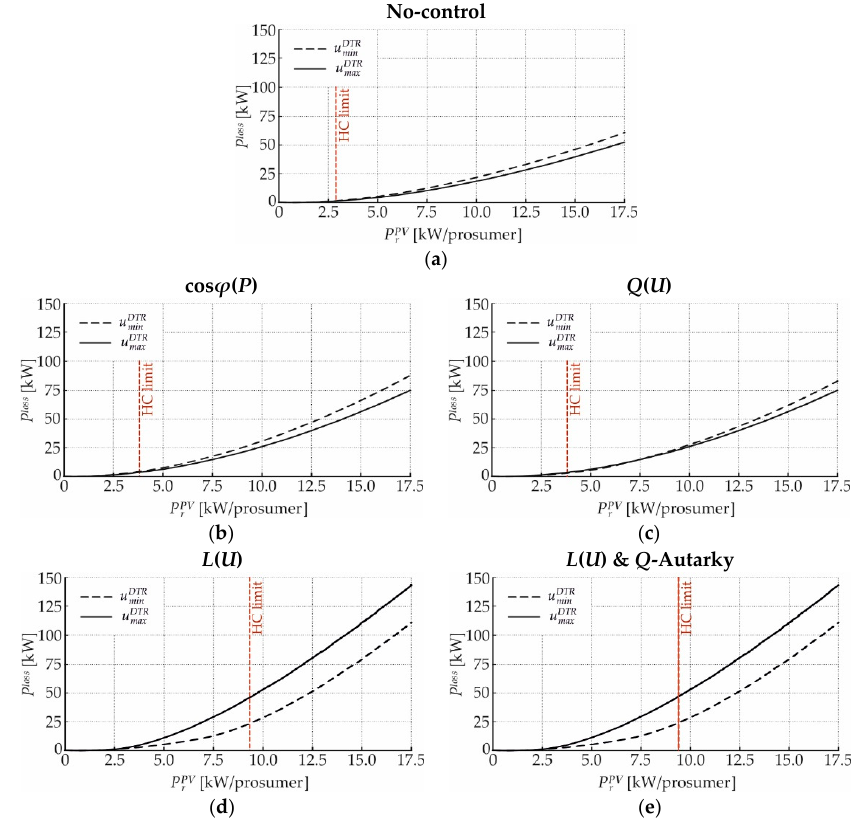
Figure 12. Grid losses of the long cable test-feeder for the minimal and maximal DTR primary voltages and different control strategies: ( a ) no-control; ( b ) cos φ ( P )-control; ( c ) Q ( U )-control; ( d ) L ( U )-control; ( e ) L ( U )-control and Q -Autarkic prosumers.